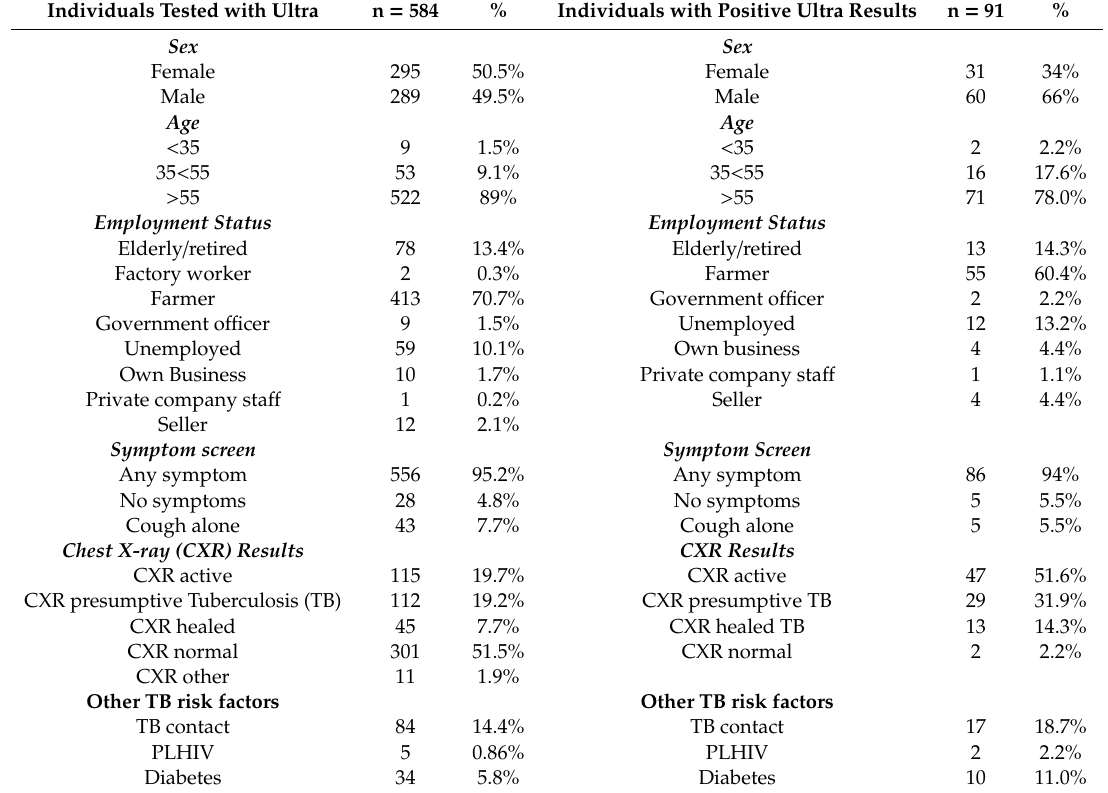
Table 1. Demographic information for individuals tested with Xpert MTB / RIF Ultra